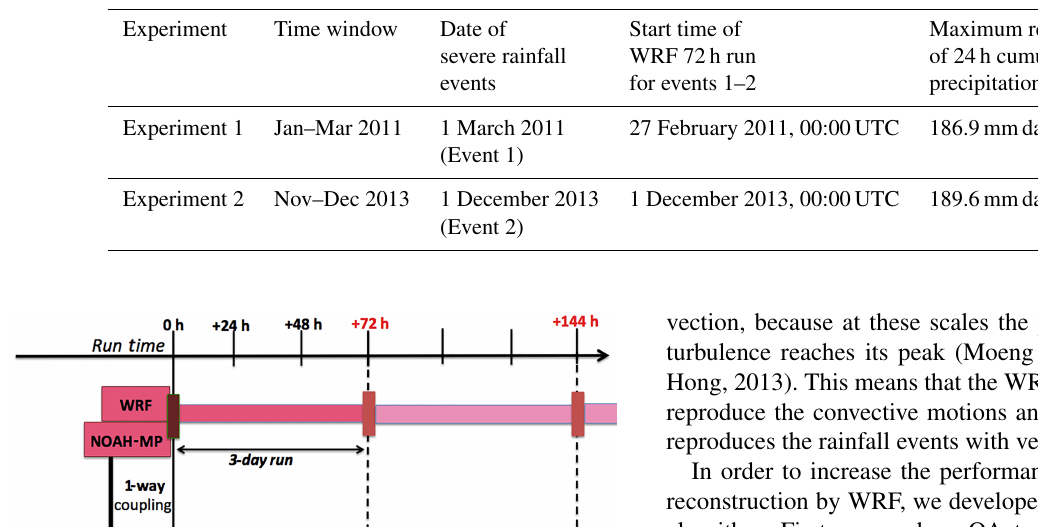
Table 2. Details on the experiments.